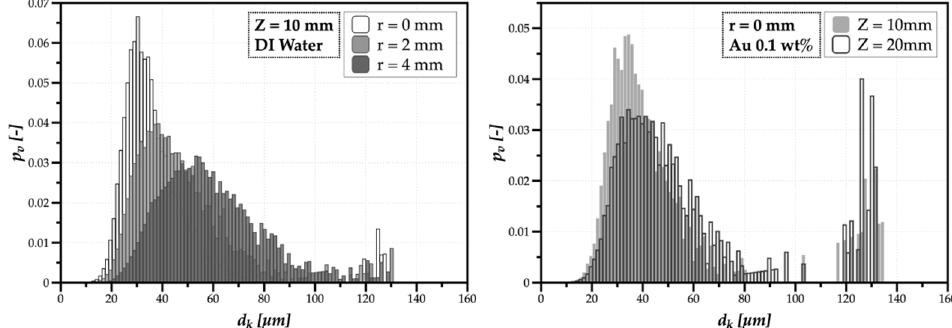
Figure 7. Example of increasing the polydispersion degree ( left ) for DI Water at Z = 10 mm; an example of a high heterogeneity degree ( right ) for the nanofluid with 0.1 wt.% of gold nanospheres at r = 0 mm.